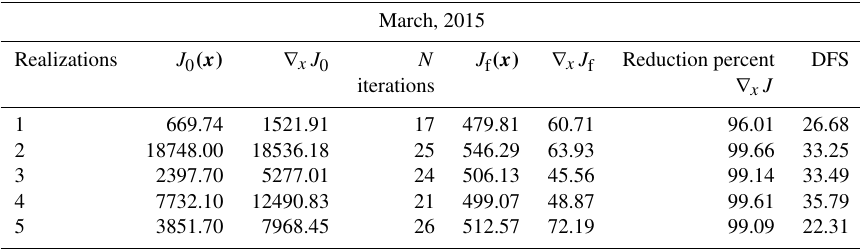
Table A3. Convergence diagnostic of the inversion system using an ensemble of five independent OSSEs for September 2015 ( ∇ x J 0 and ∇ x J 0 represent the initial cost function and its gradient at the beginning of the optimization and